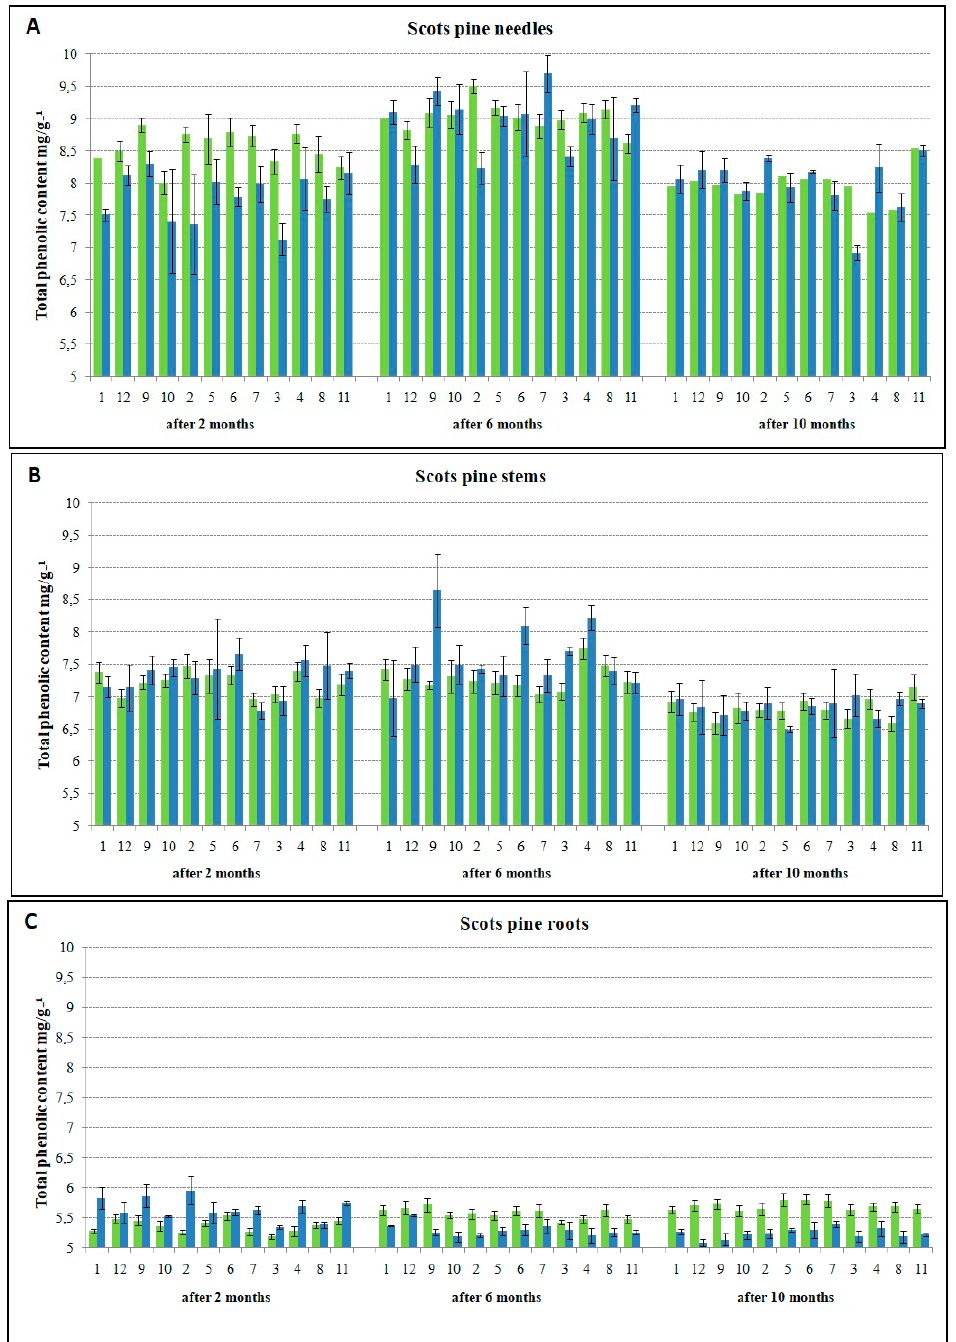
Figure 4. Concentration of total phenolic compounds (TPC) in 12 inoculated (blue column) and control (green column) group Scots pine half-sib families two, six, and ten months after inoculation: ( a ) TPC in needles; ( b ) TPC in stems, and ( c ) TPC in roots.